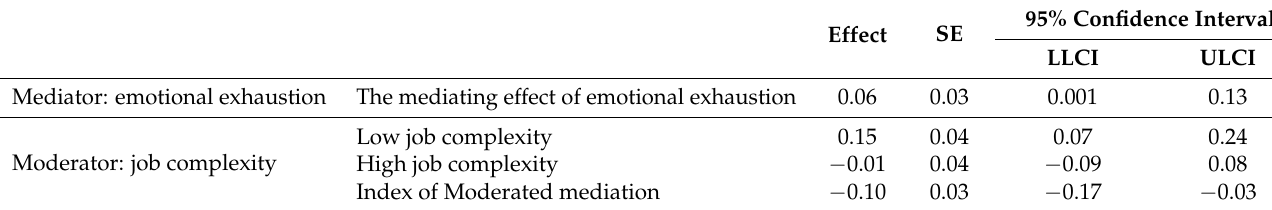
Table 5. Bootstrapping test results.